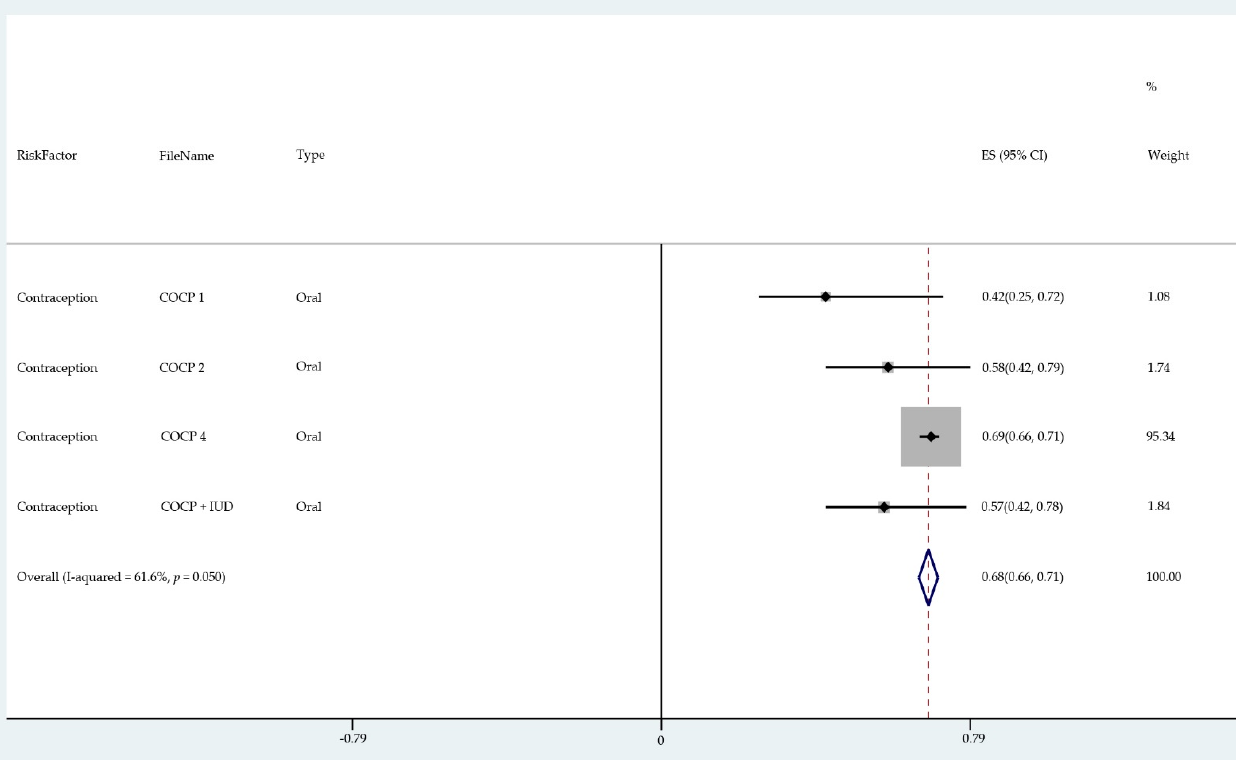
Figure 9. Forest plot to show risk of contraception (oral).